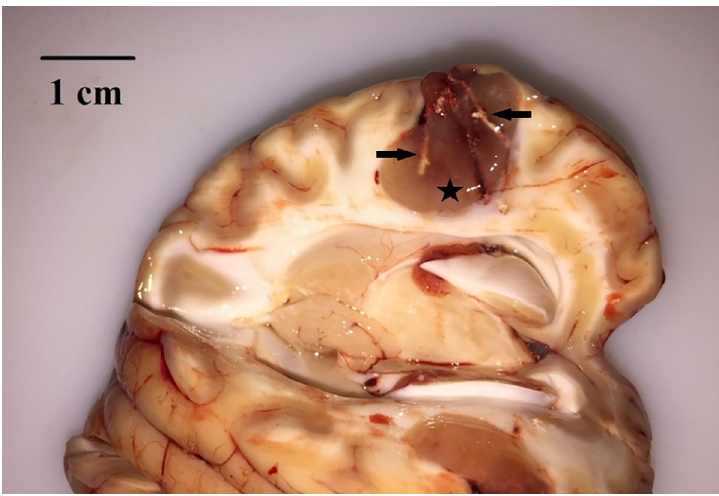
Fig 3. Injected 165 Ho inside the tumor. Sagittal section of the right hemisphere. A tumor (asterisk) is present in the temporal lobe, growing from the brain surface into the gray matter and invading the white matter. White Ho suspension streaks (black arrows) are visible inside the